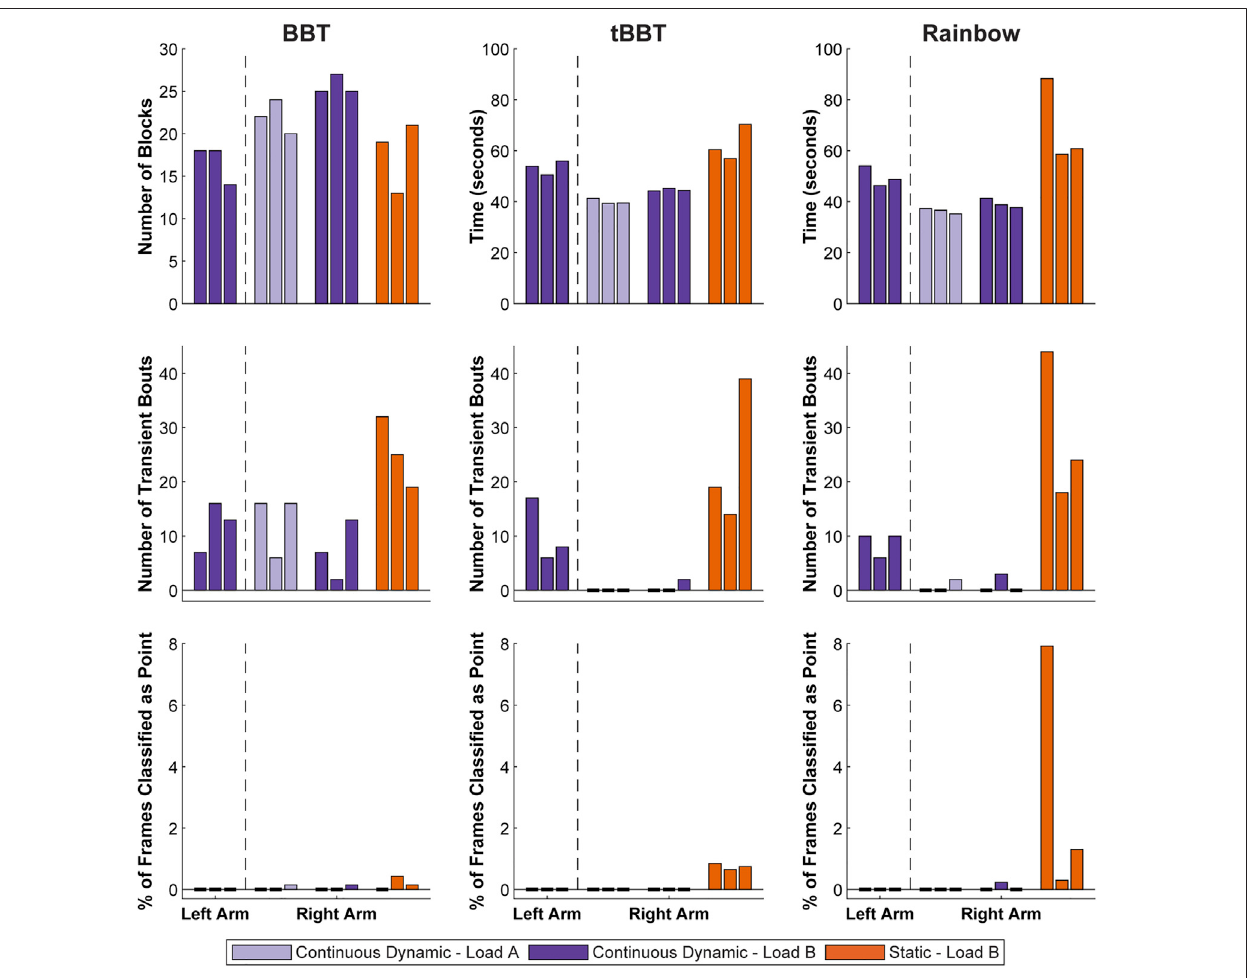
FIGURE 9 | Functional outcome measures achieved during short-term testing. Testing with the left arm was completed using a classi fi er trained with a continuous dynamic strategyunderthe loadB condition.Repeatedtestingwiththerightarmused continuousdynamic classi fi ersunderthe loadA and loadB conditions,aswellasa static classi fi er under the load B condition (BBT = Box and Blocks Test; tBBT = Targeted Box and Blocks Test).